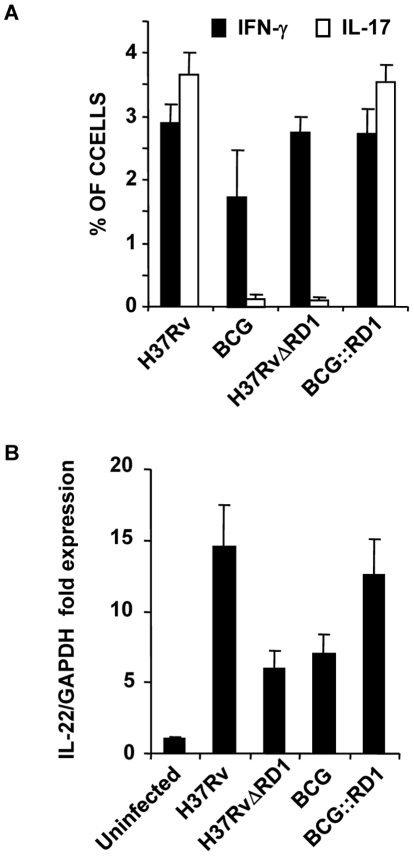
H37Rv directs differentiation of both Th1 and Th17 cells.(A) Intracellular cytokine staining for IFN-γ and IL-17 in OT-II TCR Tg CD4+ T cells co-cultured with infected DCs. (B) IL-22 mRNA expression profile from OT-II TCR Tg CD4+ T cells co-cultured with DCs after infection of DCs with H37Rv, BCG, BCG::RD1 or H37RvΔRD1. Results are representative of at least three independent experiments.